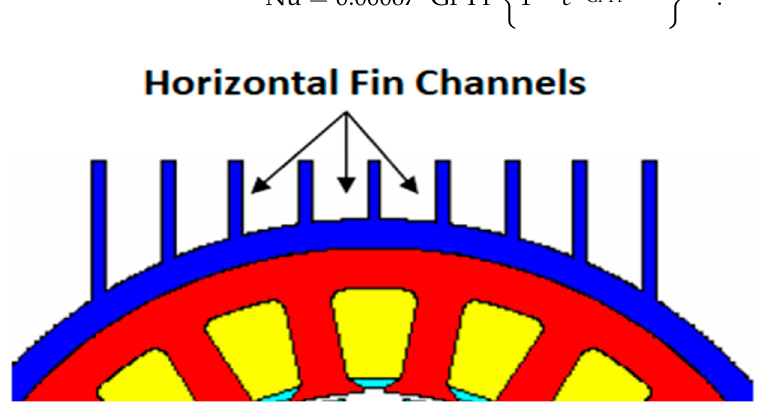
Figure 4. Horizontal fin channel schematic [23].